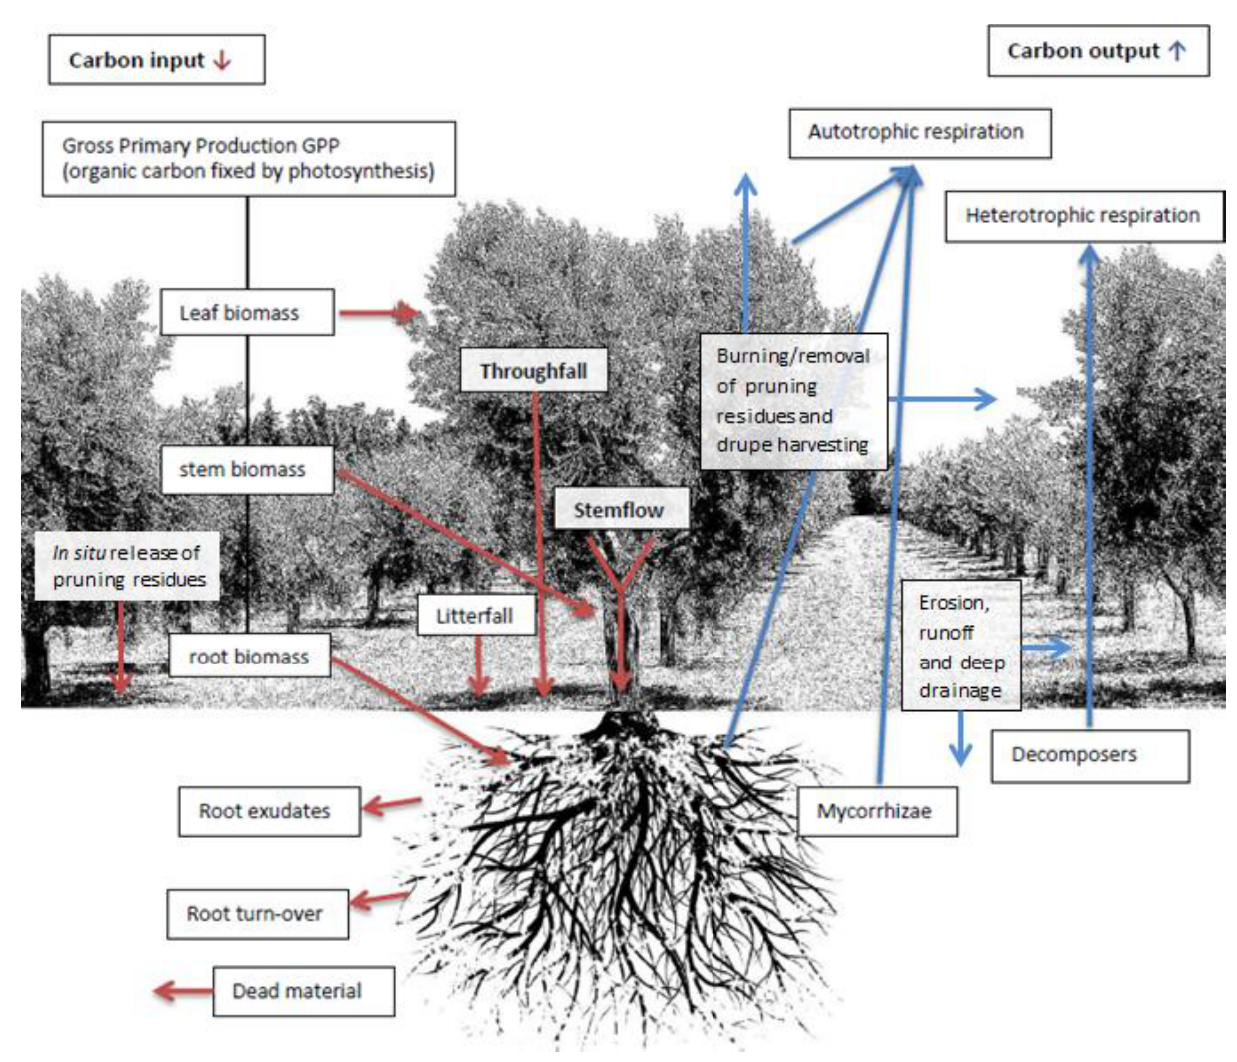
Figure 1. Carbon inputs and outputs in a typical olive grove in